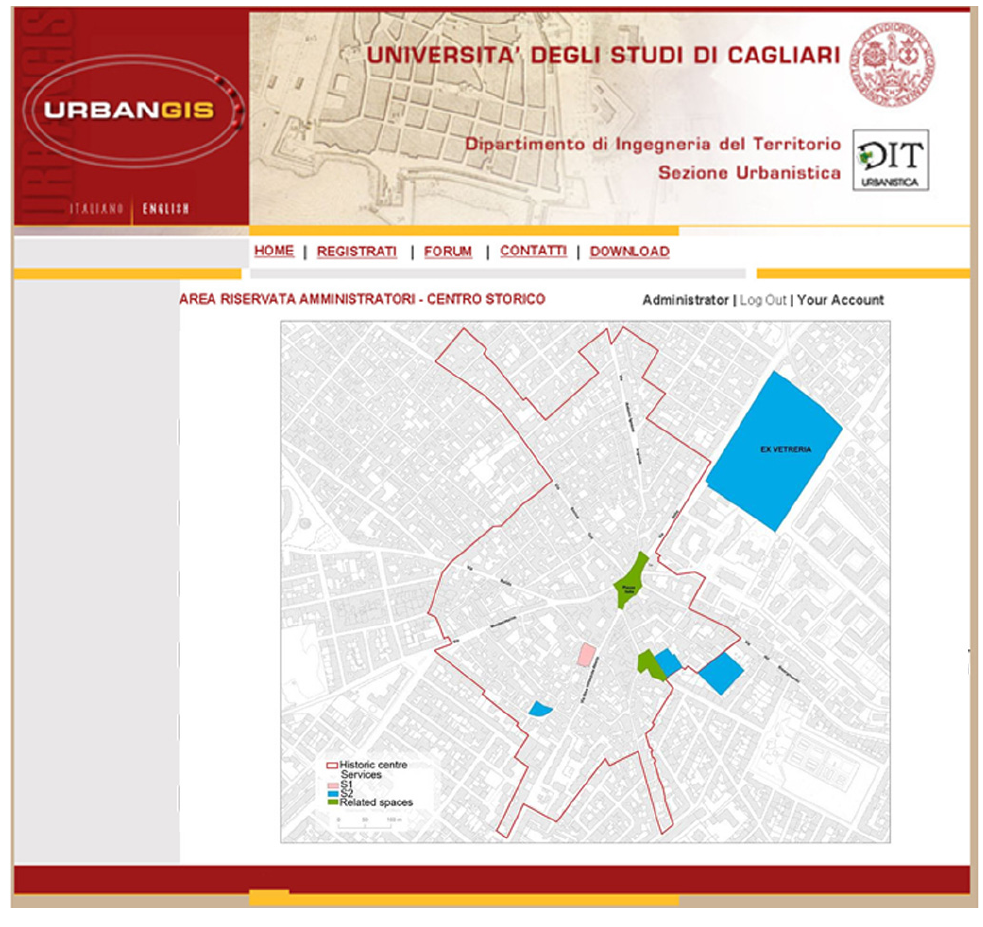
Figure 4. Proposed action—Strategic